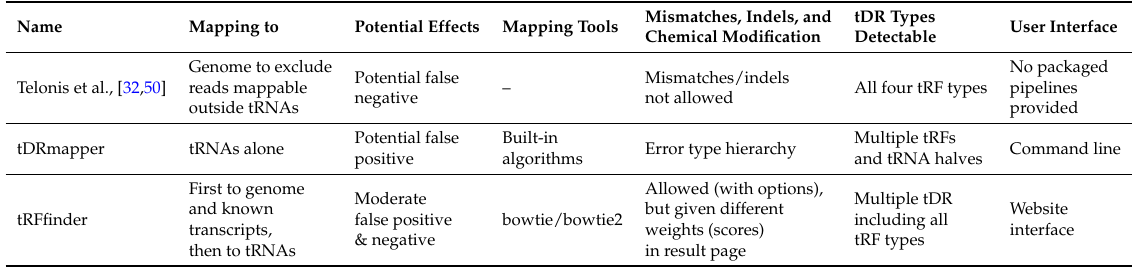
Table 1. List of tools specific to RNA-derived small RNA (tDR)